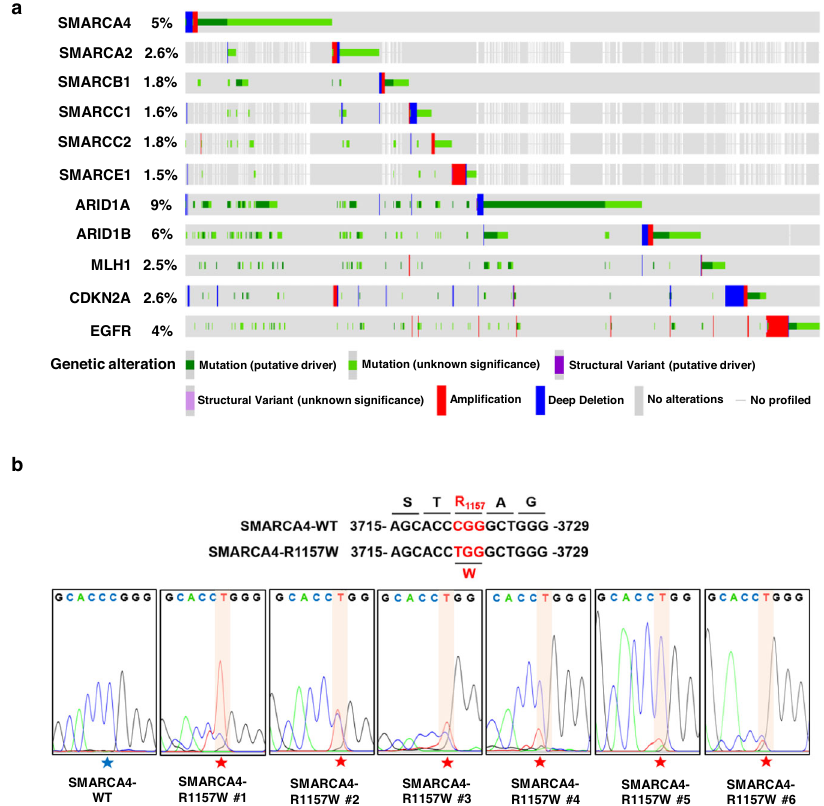
Fig. 1 Identi fi cation of speci fi c mutations of SMARCA4 in CRC patients. a Oncoprint plot showing the genomic pro fi les of SMARCA4 , SMARCA2 , SMARCB1 , SMARCC1 , SMARCC2 , SMARCE1 , ARID1A , ARID1B , and other CRC relevant genes, data compiled from the cBioPortal based on original data from TCGA CRC project. b Detection of the SMARCA4 gene showing the c. 3721C>T (p. Arg1157Trp) mutation in tumor samples of CRC patients using DNA